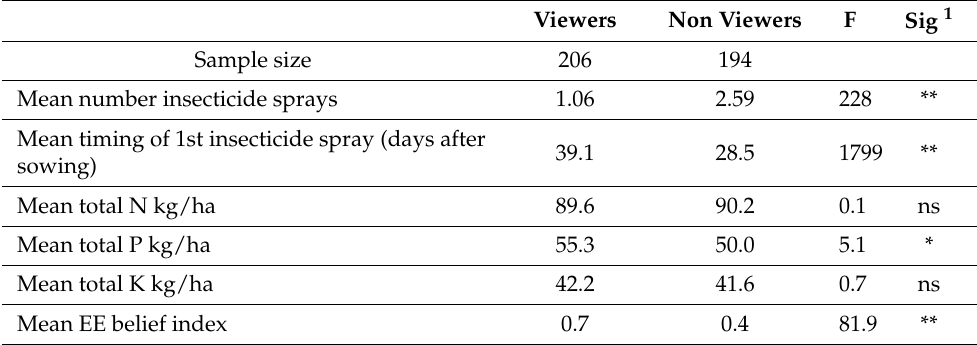
Table 3. Comparing farmers who had viewed the TV series and those who had not at 12 months after the completion of the TV series in Long An province. Viewers Non Viewers Sample